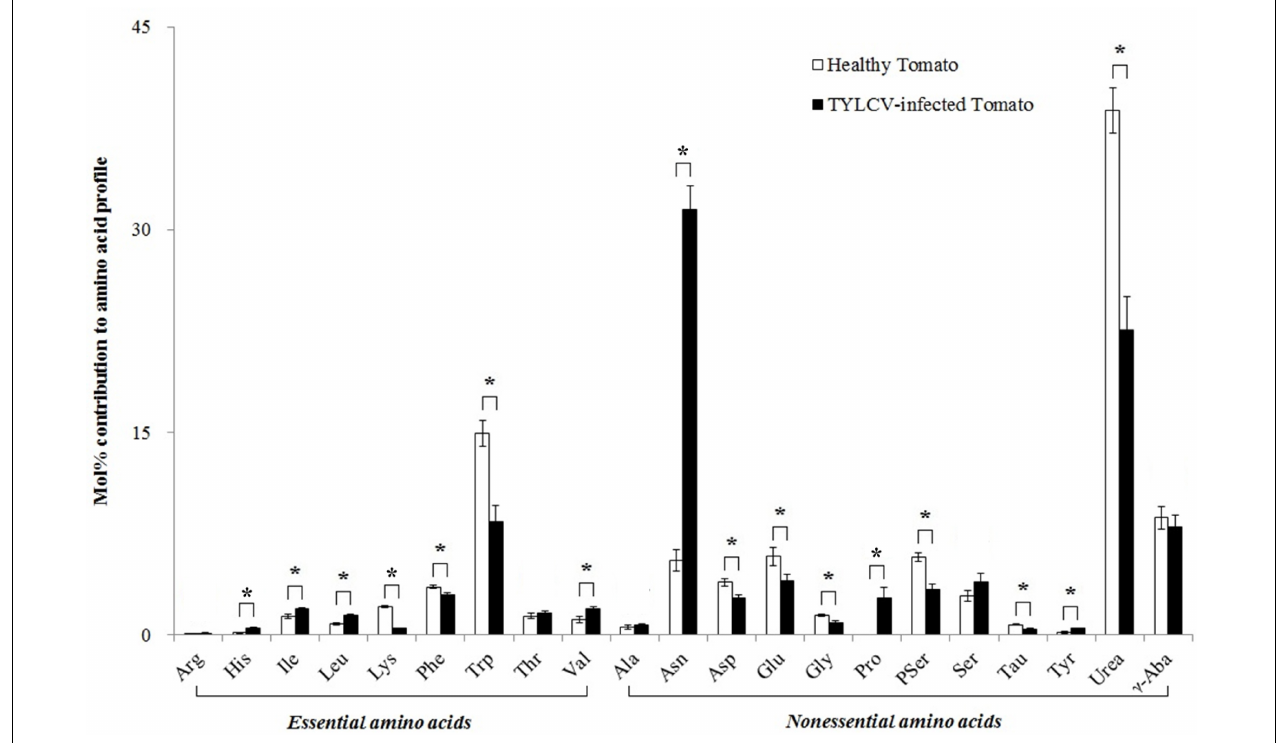
FIGURE 1 | The mol% of free amino acids in the phloem sap of healthy and TYLCV-infected tomato plants. Values are means ( ± SE) of three replicates. ∗ Indicates significant differences between healthy and TYLCV-infected tomato plants at P < 0.05; LSD test. For abbreviations, see Table 1 .